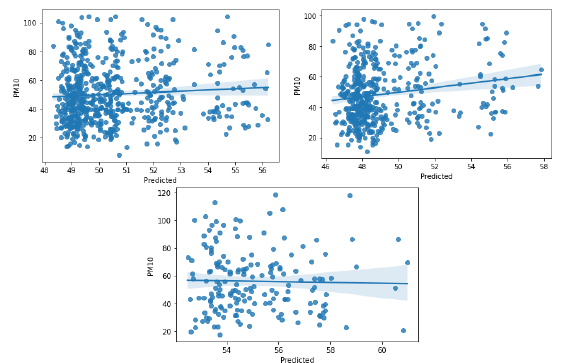
Figure 9. In-situ PM 10 vs. Predicted PM 10 plots for the yearly model (top left), dry model (top right) and wet model (bottom).